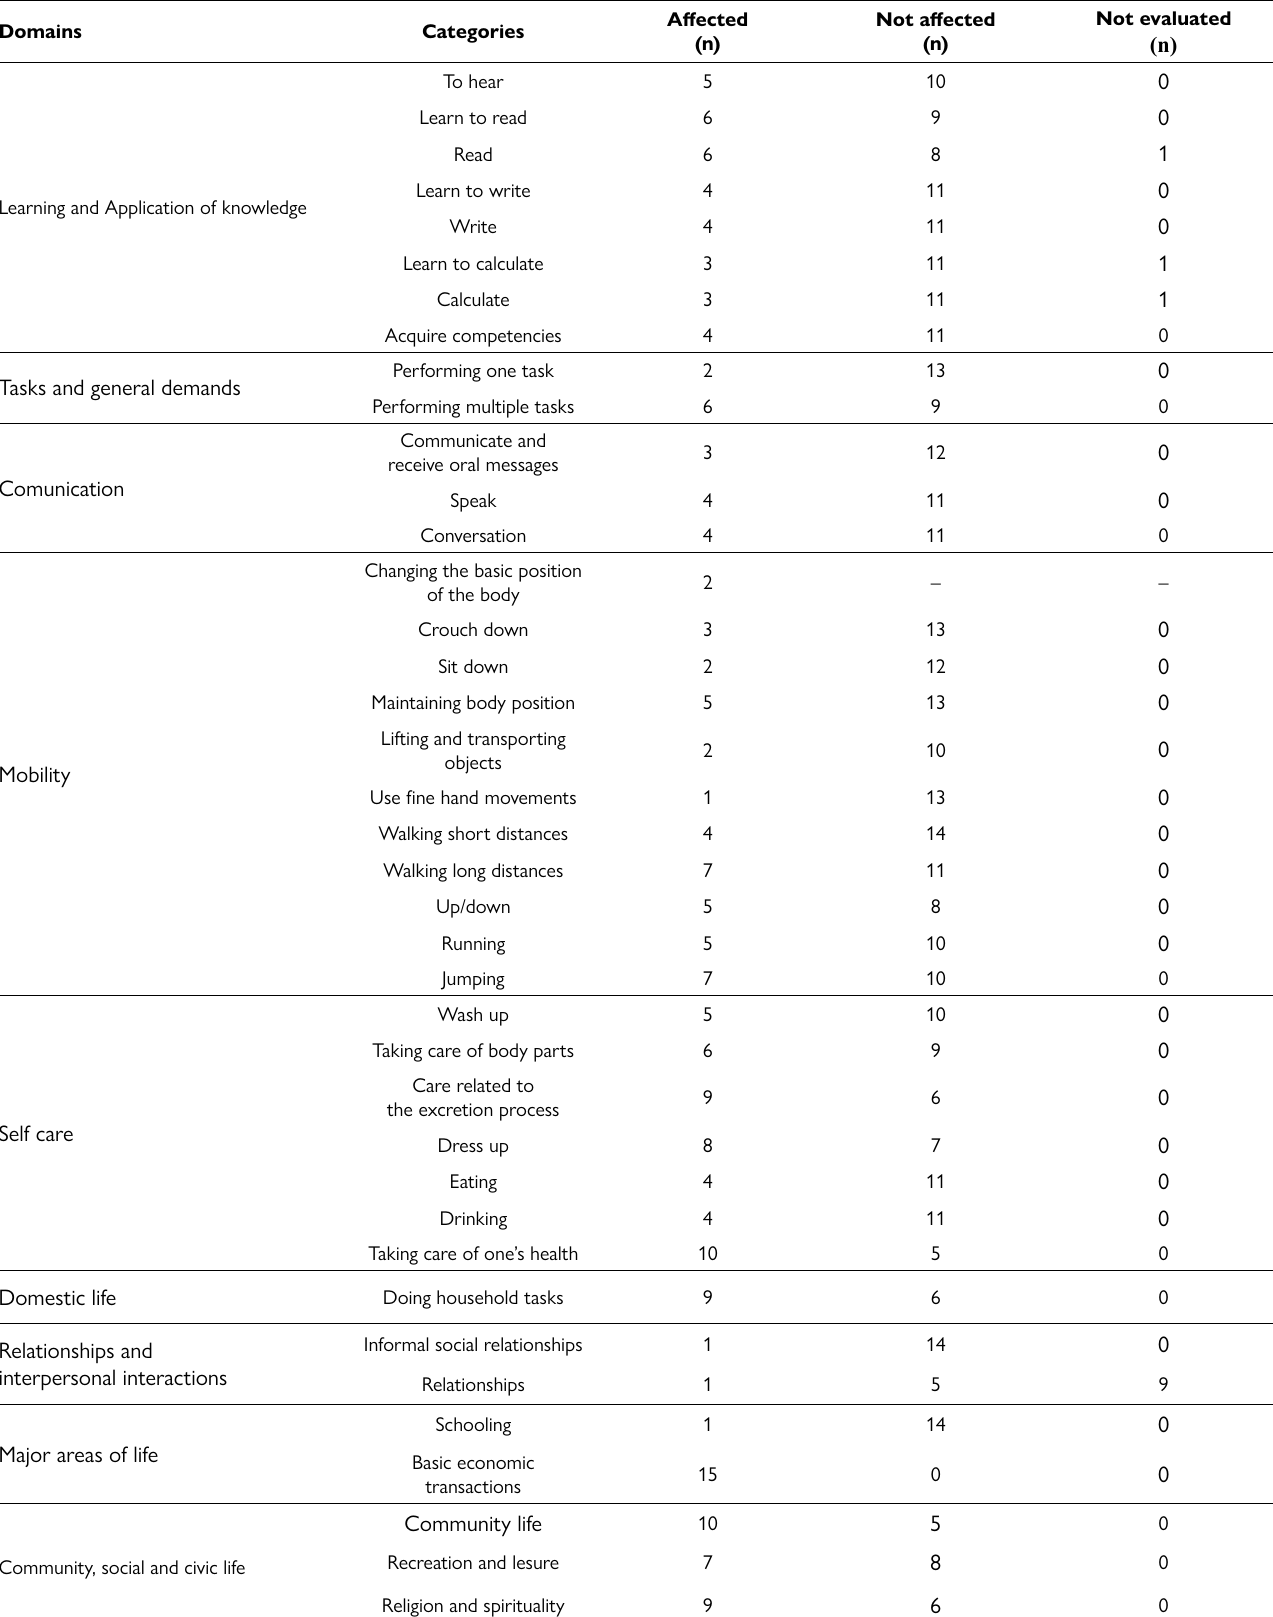
Table 3. Main changes in the components Activity and Participation of children and adolescents with MPS.